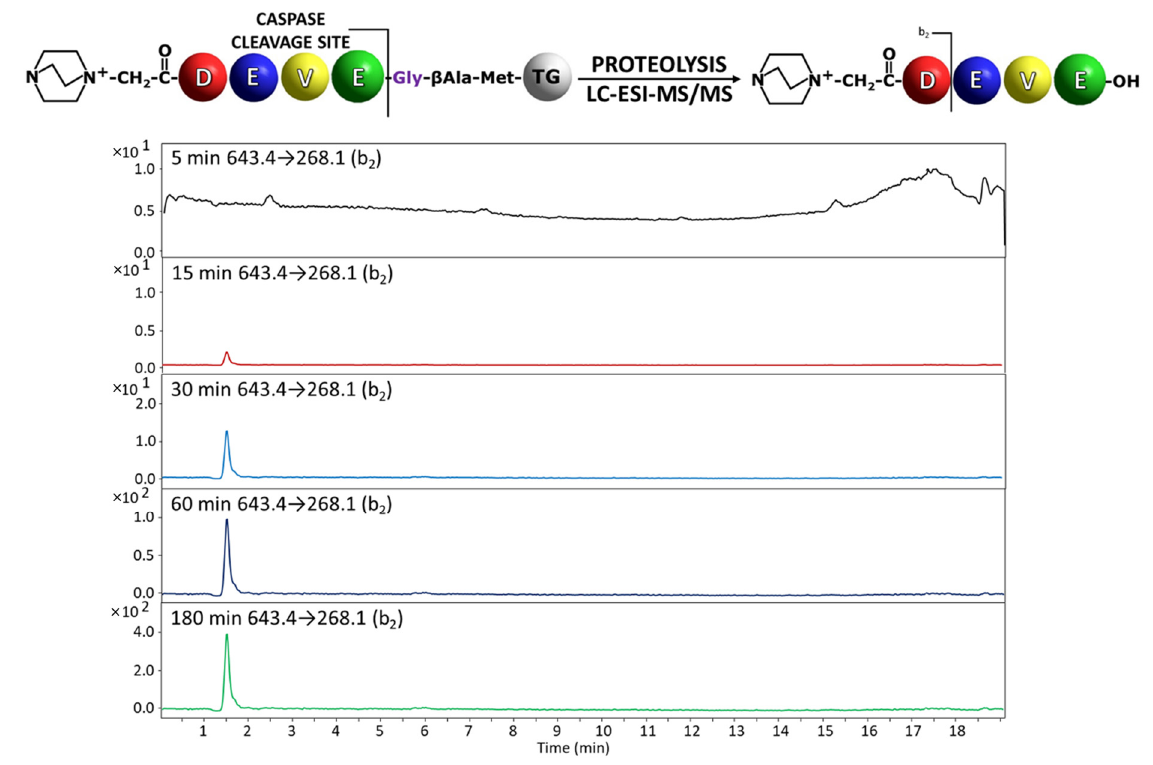
Figure 4. Chromatograms for QA-DEVE-OH peptide investigated in supernatant after incubation with caspase 3. Analyzed transition 629.4 → 268.1.